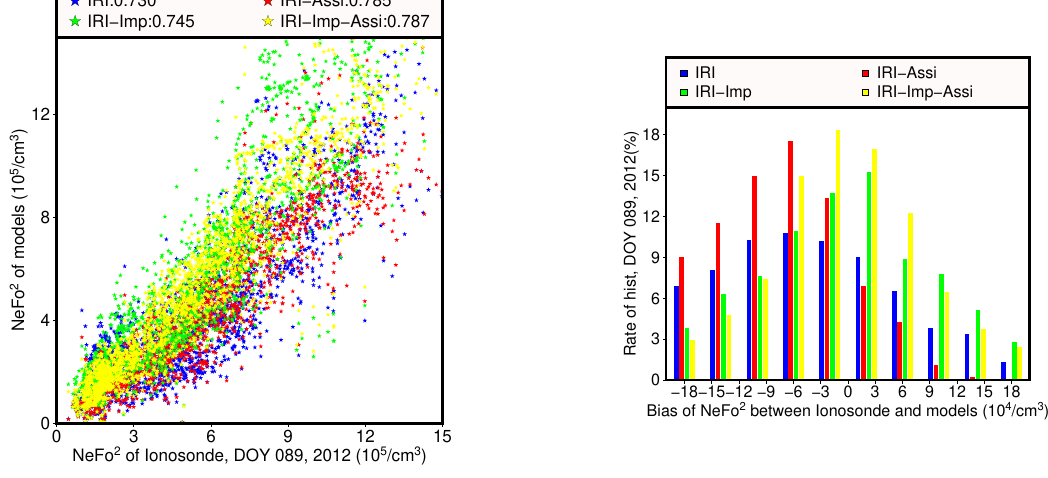
Figure 10. NeFo 2 of ionosonde and ionospheric models: ( left ) scatter plot; and ( right ) histogram plot of